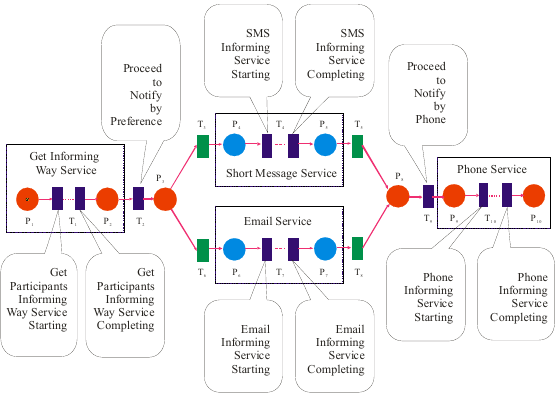
Fig.23. Conference informing services